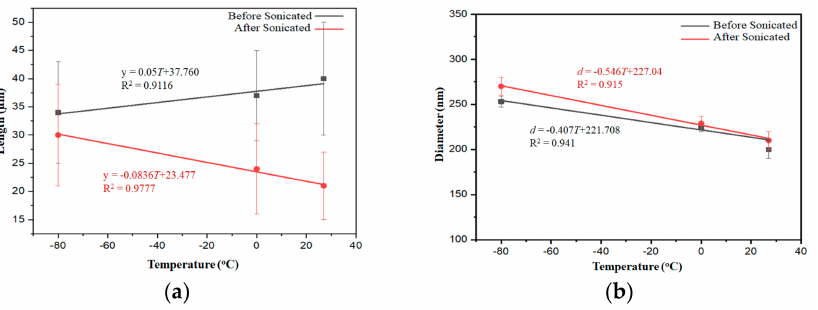
Figure 4. The relationship between the temperature of the quenching medium with ( a ) the length of AgNWs, and ( b ) the diameter of AgNWs.